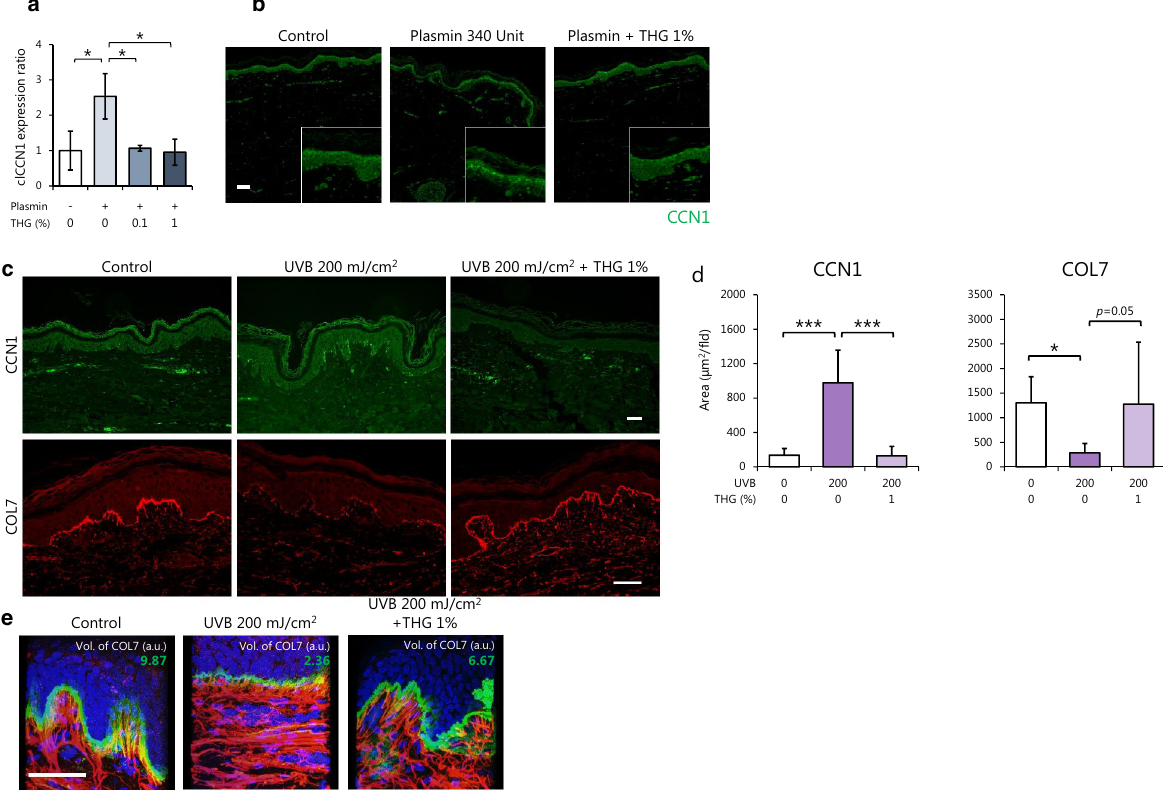
Figure 5. Treatment with THG ameliorates the structure of the basement membrane in ex vivo human skin explants. Effects of topically applied THG on CCN1 expression in plasmin-treated ex vivo skin explants. On day 1, 0–1% THG was applied on the stratum corneum and 340 U plasmin was applied to the medium. clCCN1 in the supernatant on day 5 was determined by Western Blots. Values reported are means ± SD of n = 3 replicates, Tukey’s test, * p < 0.05 ( a ). CCN1 expression and localization determined by immunohistochemistry, Bar = 100 μm ( b ). Effects of topically applied THG on the expression of CCN1 and COL7 in UVB irradiated ex vivo skin explants. 1% THG was topically treated from day 1. On days 1, 2 and 3, the inserts were exposed to 200 mJ/cm 2 UVB. The expression of CCN1 and COL7 was determined by immunohistochemistry of skin sections collected on day 5, Bar = 50 μm ( c ). The area of CCN1 and COL7 around the basement membrane was quantified. Values reported are means ± SD of 9 fields from n = 3 replicates, Tukey’s test, * p < 0.05, *** p < 0.001 ( d ). The volume of COL7 and ELN was determined by immunohistochemistry of decolorized skin explants, Bar = 50 μm ( e